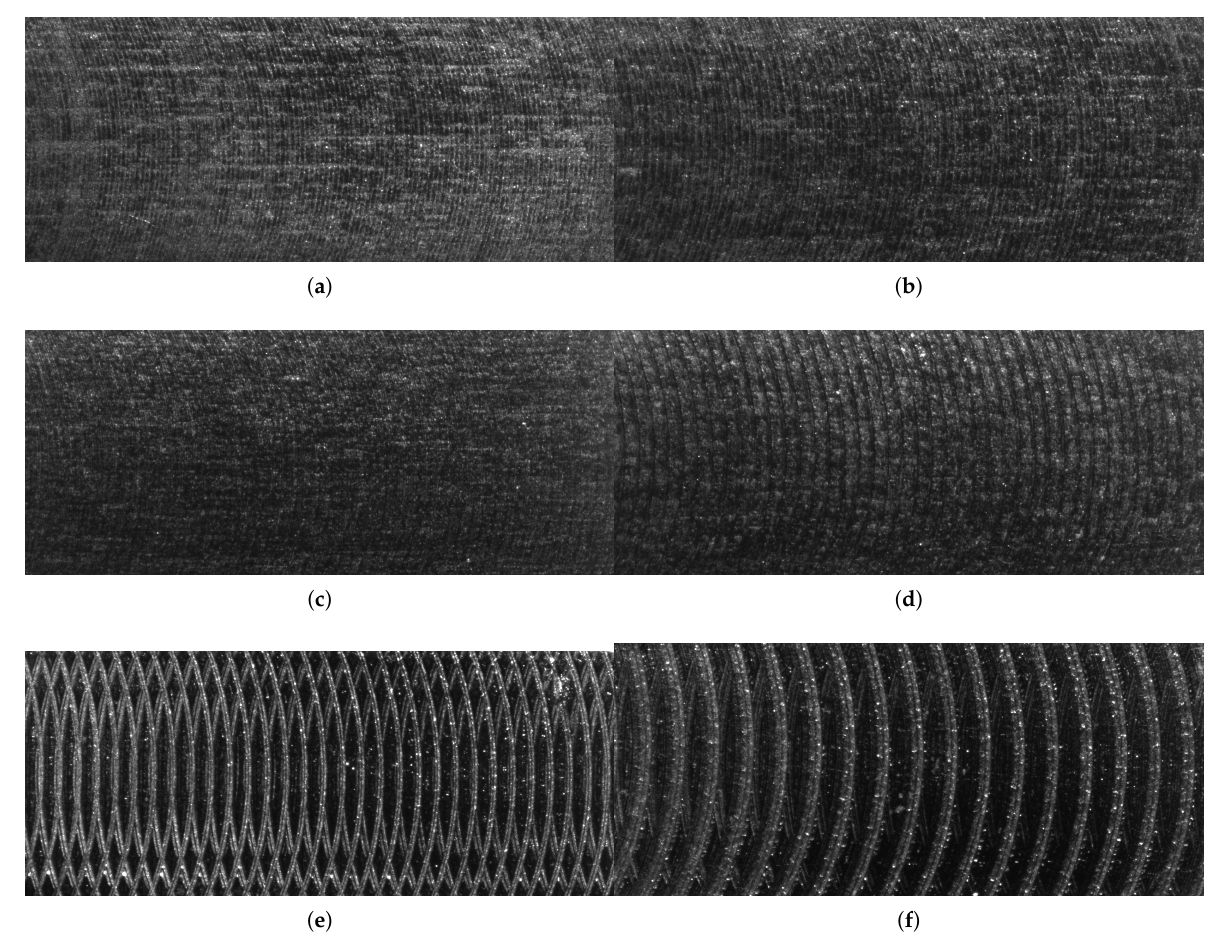
Figure 13. Raw RTI data of surface state obtained by an end milling process from a surface assembly for roughness control (Rubert n ◦ 130); θ = 80 ◦ ; φ = 72 ◦ : ( a ) Surface R1; Rz = 2.5; Ra = 0.4; ( b ) Surface R2; Rz = 4.0; Ra = 0.8; ( c ) Surface R3; Rz = 8.0; Ra = 1.6; ( d ) Surface R4; Rz = 16; Ra = 3.2; ( e ) Surface R5; Rz = 32; Ra = 6.3; ( f ) Surface R6; Rz = 50; Ra =